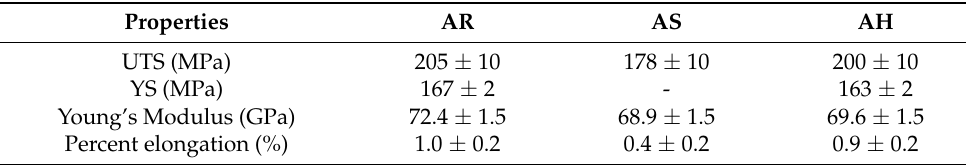
Table 6. Tensile test results for as-cast gearcase.